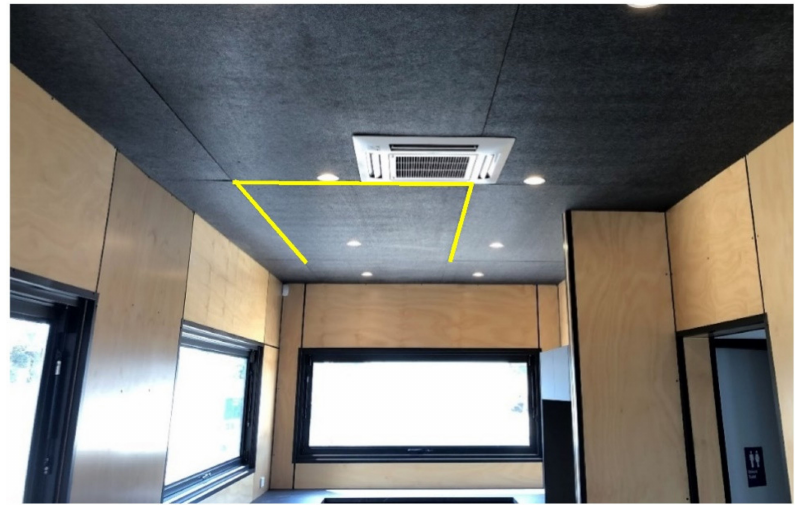
Figure 3. Disassemblable and resilient ceiling and cladding.